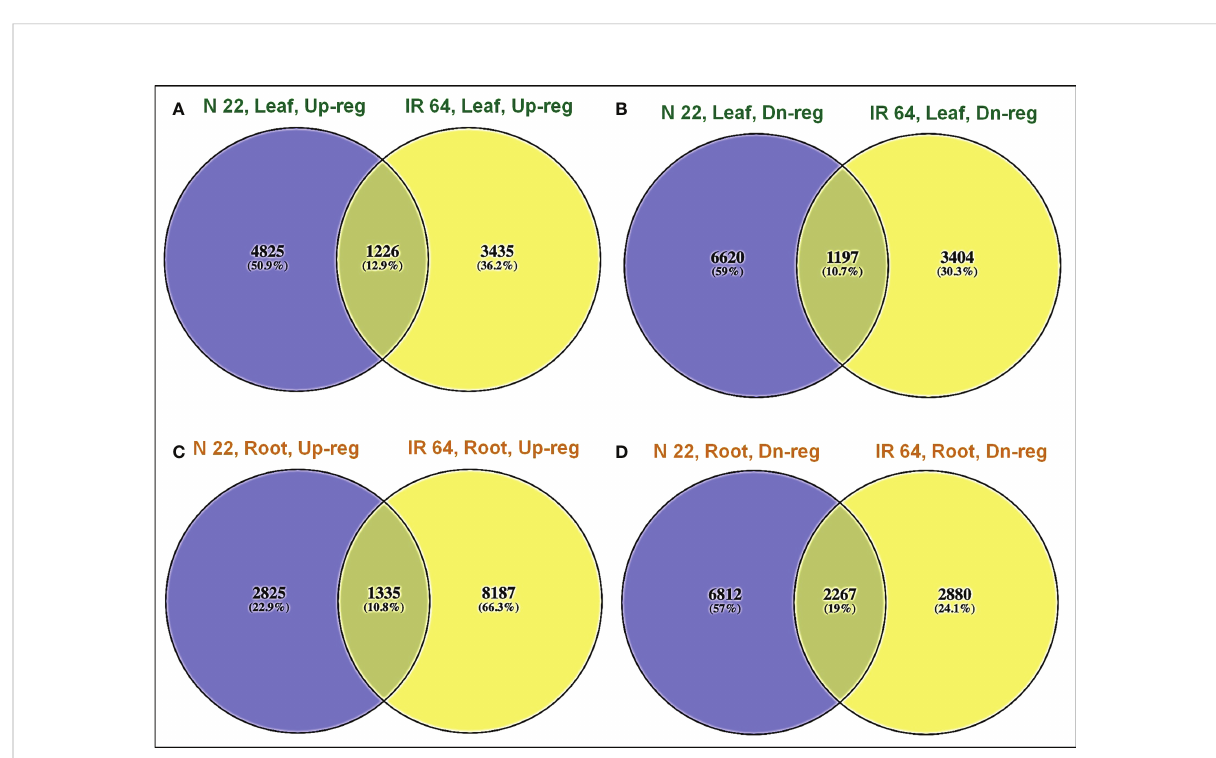
FIGURE 5 Venn diagram showing differential expression of genes in rice cultivars [IR 64 and Nagina 22 (N 22)] on direct-sowing over transplanting under drought stress. (A) Up-regulated, (B) down-regulated genes in leaf, (C) up-regulated, (D) down-regulated genes in root of N 22 and IR